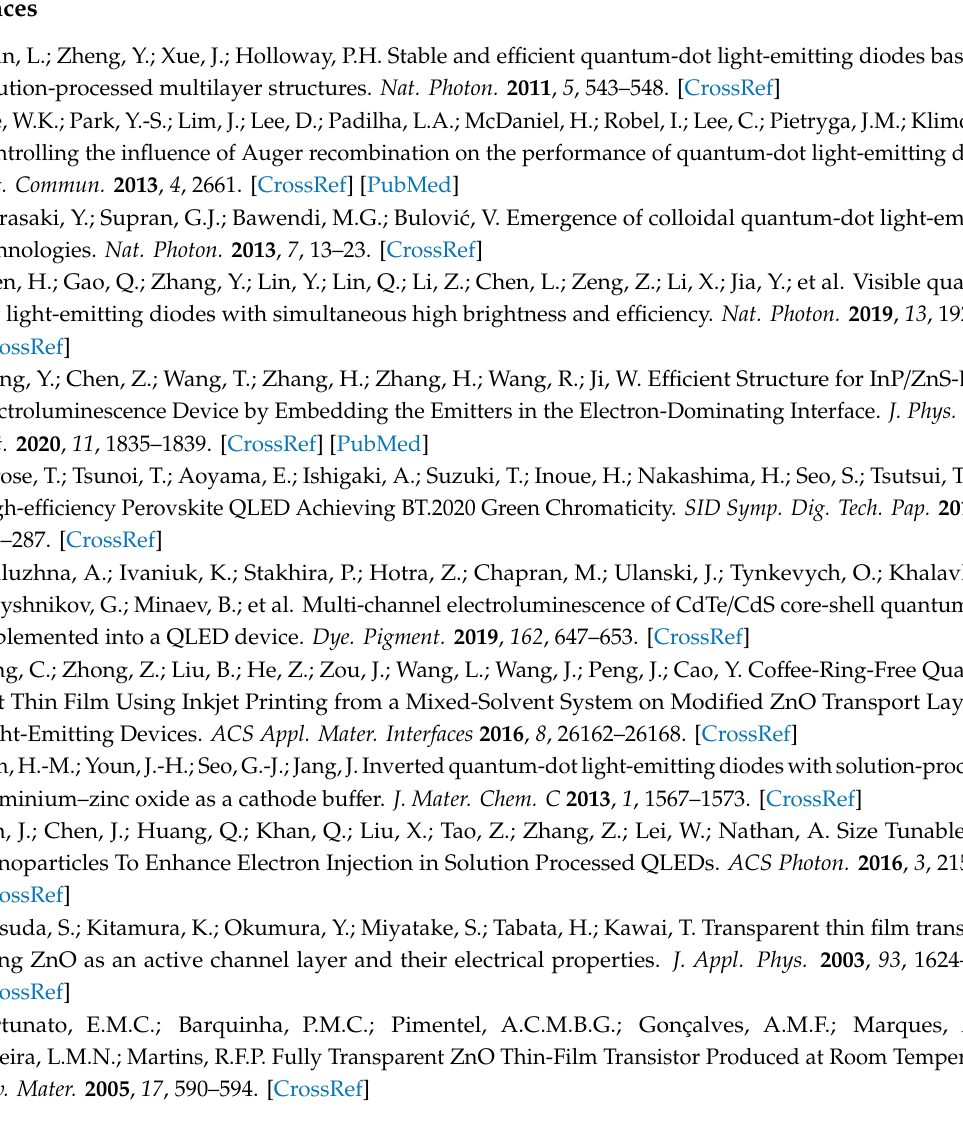
Figure S1: Typical log-log plot of the current density-voltage characteristics of QLEDs. Based on this theory of current behavior in the device, we conducted an 8-day measurement of the current density behavior of HODs and EODs, in addition to QLEDs; the e ff ects of atmospheric oxygen and moisture on the device and the tendency of the ZnO NPs ETL characteristics during IPL post-treatment were analyzed, Figure S2: Current density-voltage characteristics of the HODs (a) with and (b) without encapsulation and the EODs (c) with and (d) without encapsulation. By encapsulation, in the HODs, deterioration of device performance due to moisture and oxygen due to organic materials was improved. In the EODs, decrease of current density in OC and T-SCLC regions over time was consistently improved, Figure S3: IVL characteristics of the spin-coated QLEDs (a–c) with and (d–f) without encapsulation (Inset of (a) and (d): log-log plot of the current density-voltage curve). QLEDs has a tendency to maintain a constant current density by encapsulation, and the e ffi ciency curves is almost constant from the after 1